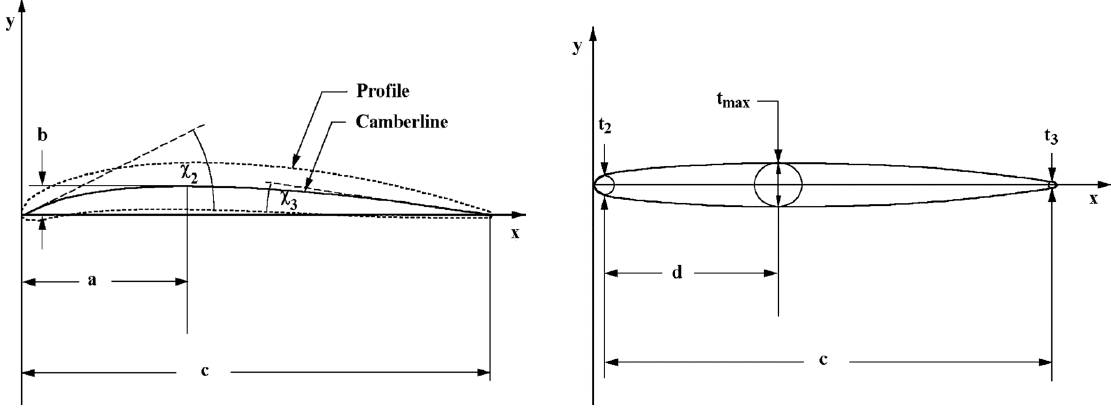
Figure 4. Nomenclature of a typical airfoil geometry.